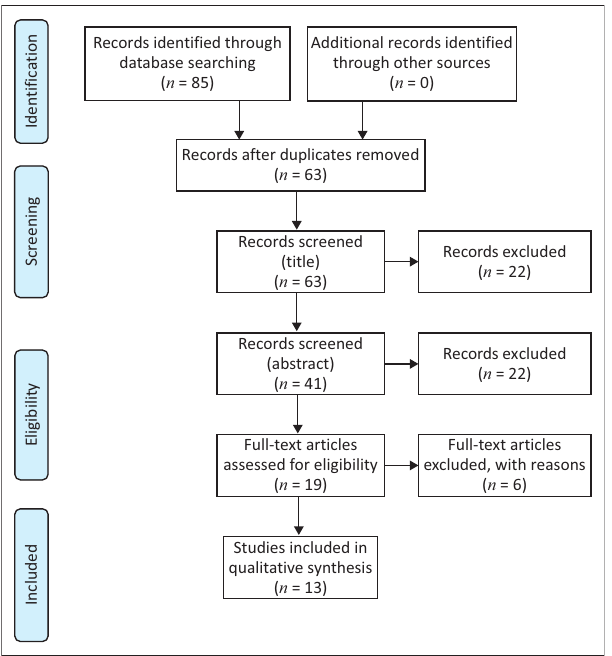
FIGURE 1: PRISMA 2020 flow diagram for the current scoping review which included searches of databases and other